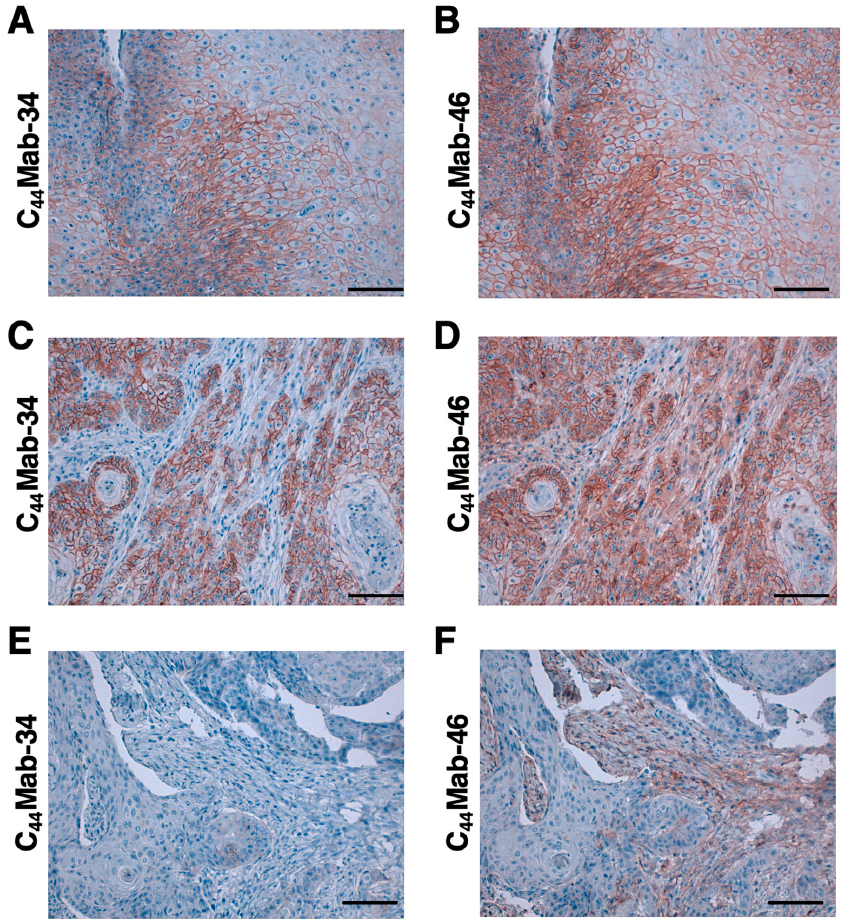
Figure 5. Immunohistochemical analysis using C 44 Mab-34 and C 44 Mab-46 against OSCC tissues. After antigen retrieval, serial sections of OSCC tissue array (Catalog number: OR601c) were incubated with 10 µ g/mL of C 44 Mab-34 ( A, C, E ) or 1 µ g/mL of C 44 Mab-46 ( B, D, F ), followed by treatment with the Envision+ kit. The chromogenic reaction was conducted using 3,3 (cid:48) -diaminobenzidine tetrahydrochloride (DAB). The counterstaining was performed using hematoxylin. Scale bar = 100 µ